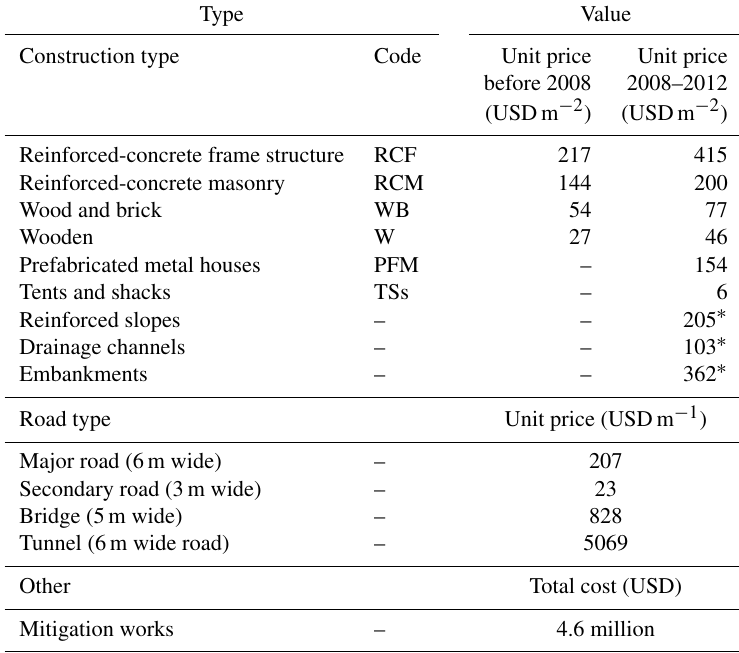
Table 5. Price of built-up features. All values were adjusted to the situation of 2012 by the inflation rate of Chinese yuan. ∗ Calculated based on the mitigation design of a nearby